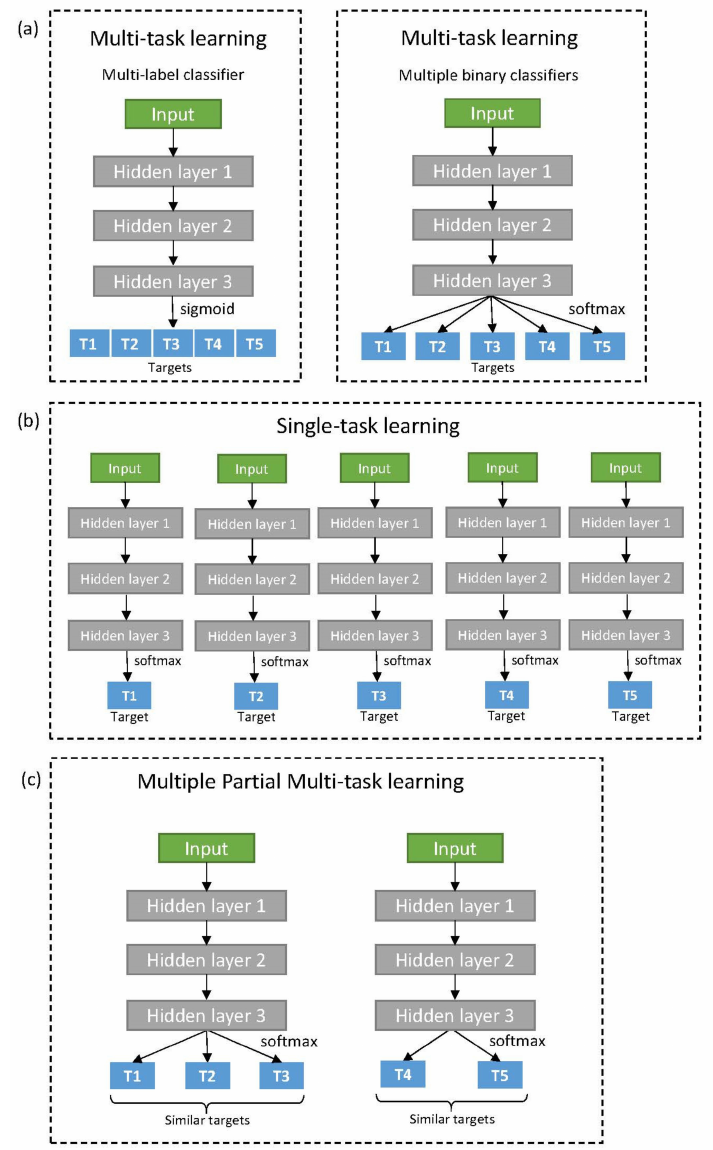
Figure 1. Various deep neural architectures for multi-task and single-task learning: ( a ) Multi-task learning architectures for two types of target specific output neuron; Multi-label classifier (left) and Multiple binary classifiers (right); ( b ) Single-task learning; ( c ) Multiple Partial Multi-task learning which separates targets into multiple partial target sets for training together by multi-task